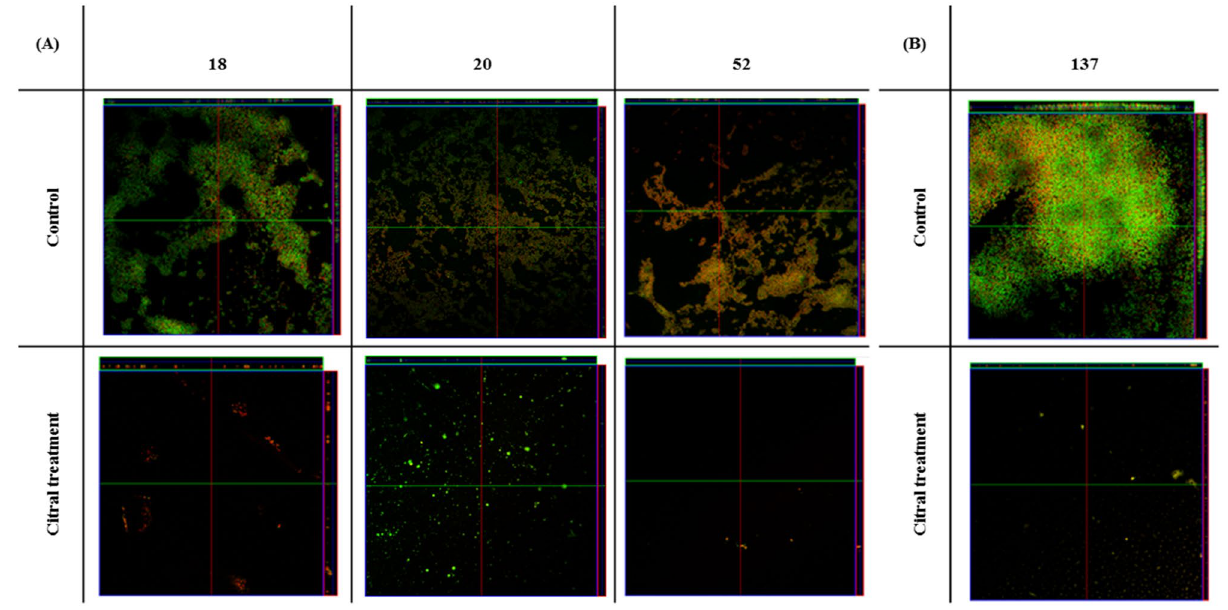
Figure 3. Confocal microscopy showing biofilm formation of isolated MRSA (18, 20, and 52) (control) and treated with citral 25 mg/mL (2.5%) for 24 h (A) and isolated MRSA (137) (control) and treated with citral 25 mg/mL (2.5%) for 48 h (B) . The microorganisms were marked with SYTO9 (green) and unviable with propidium iodide